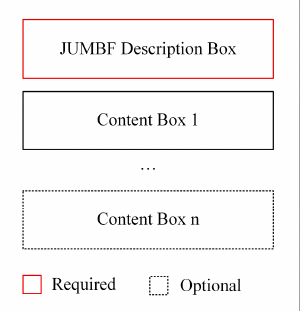
Figure 2. General structure of JUMBF super box.